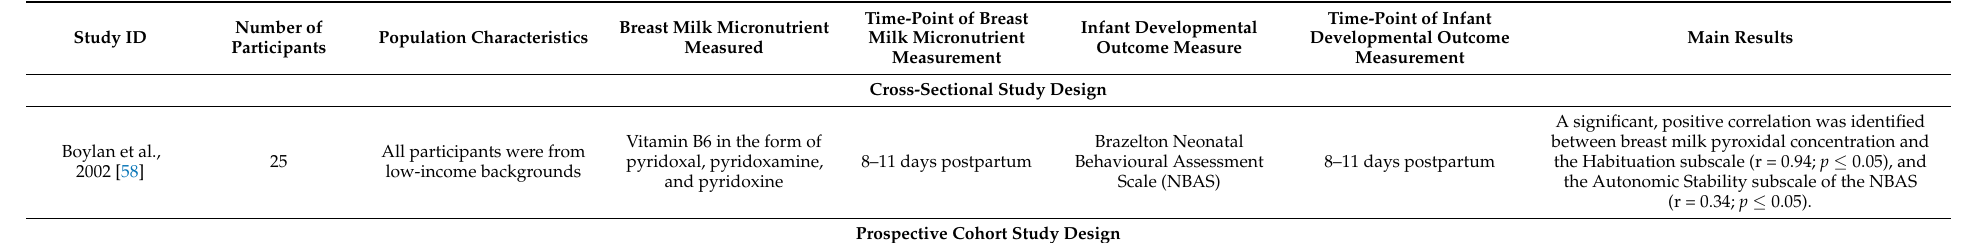
Table 1. The study design and main results of each included study ( n =